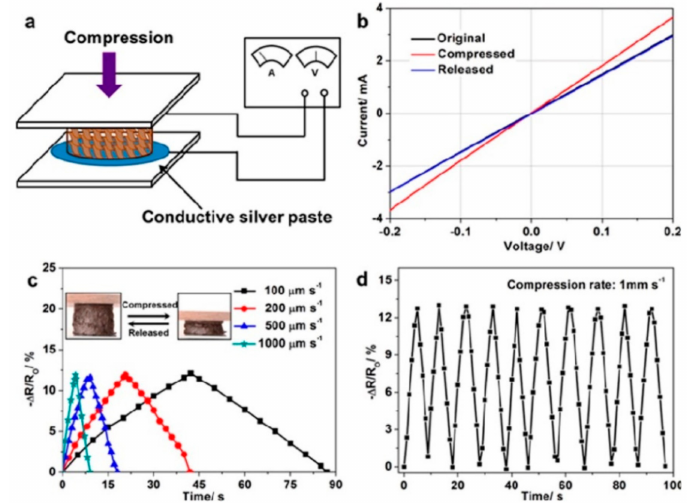
Figure 10. Electromechanical behaviors of graphene aerogel / plasma desorption ionization mass spectrometry (PDMS) composites. ( a ) Setup for testing; ( b ) Current-Voltage curves; ( c ) Resistance change with strain at di ff erent compression rates; ( d ) Resistance change with at fixed compression rate. Reproduced with permission from [138]. Copyright 2014, American Chemical